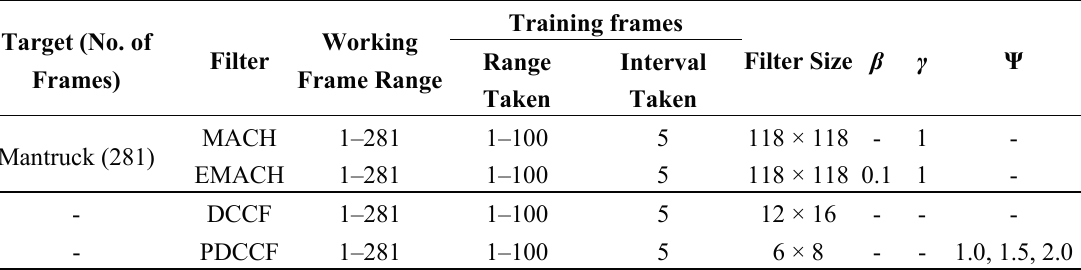
Table 2. Training data for Sequence L1415.